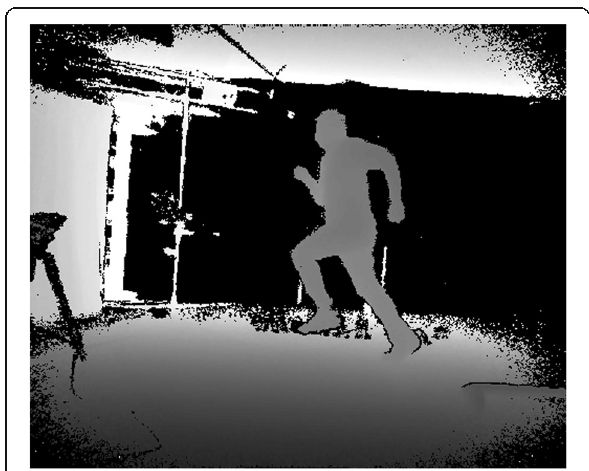
Fig. 2 Example of a depth map. Brighter pixels are further away from the camera. Black pixels are either too far away or on objects that do not reflect near infrared light